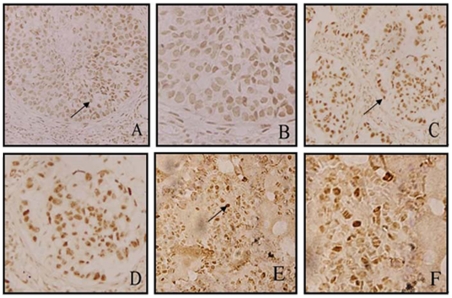
LSD1 expression and distribution in NSCLC tumor tissues and normal lung tissues, detected by IHC staining. (A, B) LSD1 expression was up-regulated in lung squamous cancer tissue. The arrows indicate LSD1-positive cancer cells, which were located in the cell nuclei. Magnification: A, ×20; B, ×60. (C, D) LSD1 expression was up-regulated in lung adenocarcinoma cancer tissue. Magnification: C, ×20; D, ×60. (E, F) IHC revealed that LSD1 expression was weak in normal lung tissues. Magnification: E, ×20; F, ×60. IHC scores of LSD1 expression were: low, [0 (negative) ≤ score < 2+]; high, [2+ ≤ score ≤3+]. P<0.05 indicated statistically significant differences between groups.